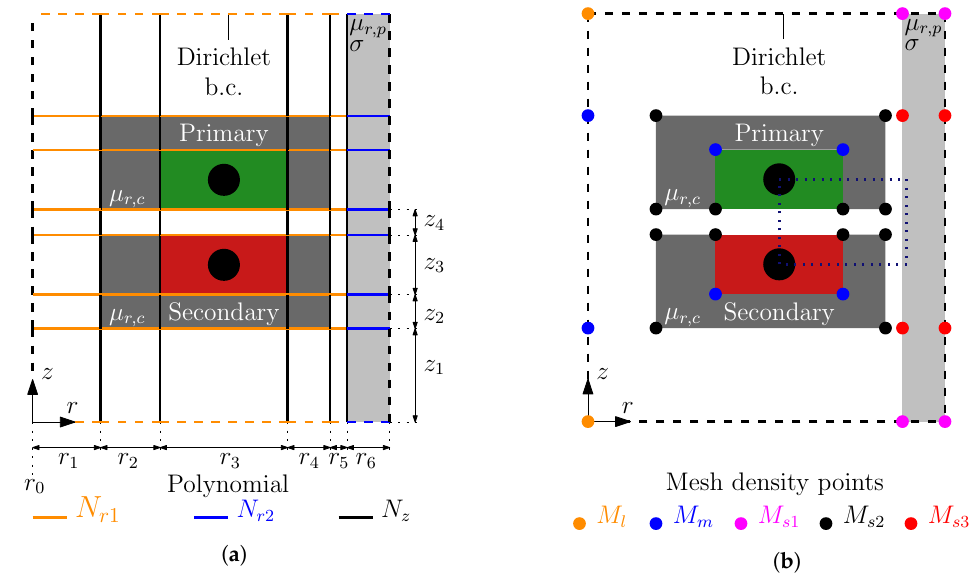
Figure 2. Overview of the investigated domain in two dimensions, including boundary conditions (b.c.), geometrical parameters, material properties, and discretization of ( a ) elements and polynomial degree in the Spectral Element Method (SEM) model and ( b ) minimum element sizes (mesh points) in the Finite Element Method (FEM) model. Table 1. Geometrical parameters and physical quantities of the investigated benchmark